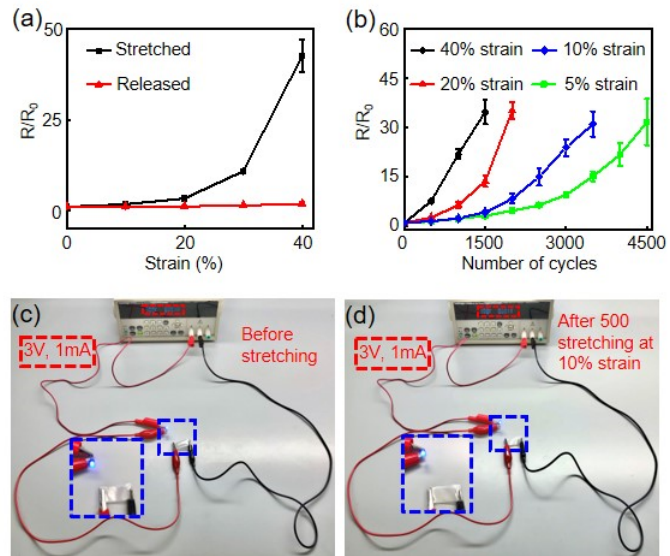
Figure 2. ( a ) Relative changes of resistance under stretching strain. ( b ) Relative changes of resistance after cyclic stretching cycles to different strains. R 0 is the resistance before stretching, whereas R represents the resistance at a specific stretching cycle. The results are averaged over 5 devices. Photos of an operating blue LED connected by Ag NW/PDMS films ( c ) before and ( d ) after 500 stretching cycles at 10% strain.